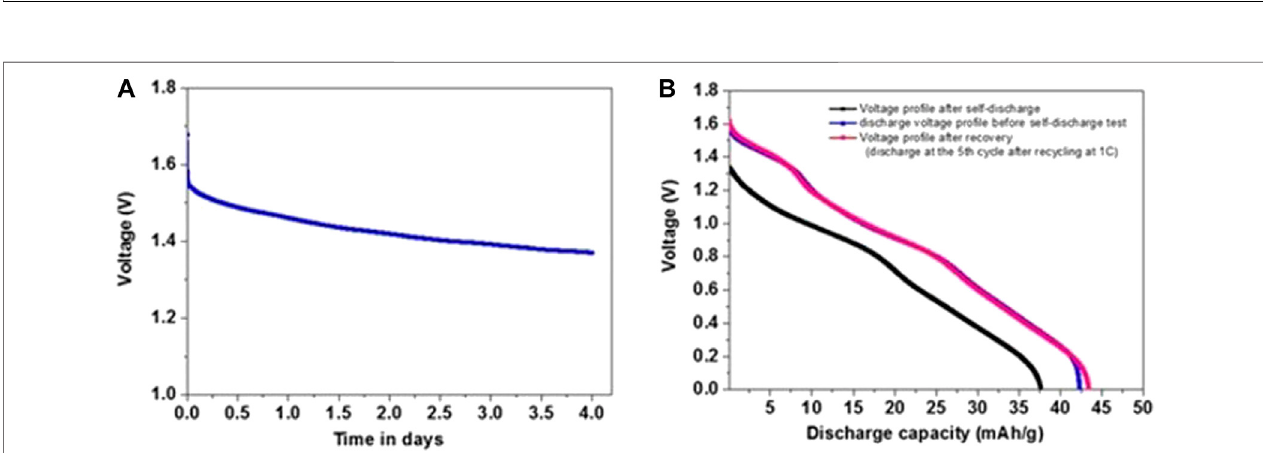
FIGURE 13 | (A) OCV changes of charged NMO/PI full cells held at 1.7 V after being cycled at 1C rate 10 times. (B) Representative discharge voltage-capacity pro fi lesofthesecellsbeforetheself-dischargeexperiment(inblue)andafterbeingheldatthechargedstateduring4daysinordertomeasuretheirself-discharge(black). The voltage pro fi le in pink belongs to a typical discharge process ( fi fth cycle) of these cells upon their recycling after the end of the self-discharge experiment (storing the charged cells at OCV during 4 days).